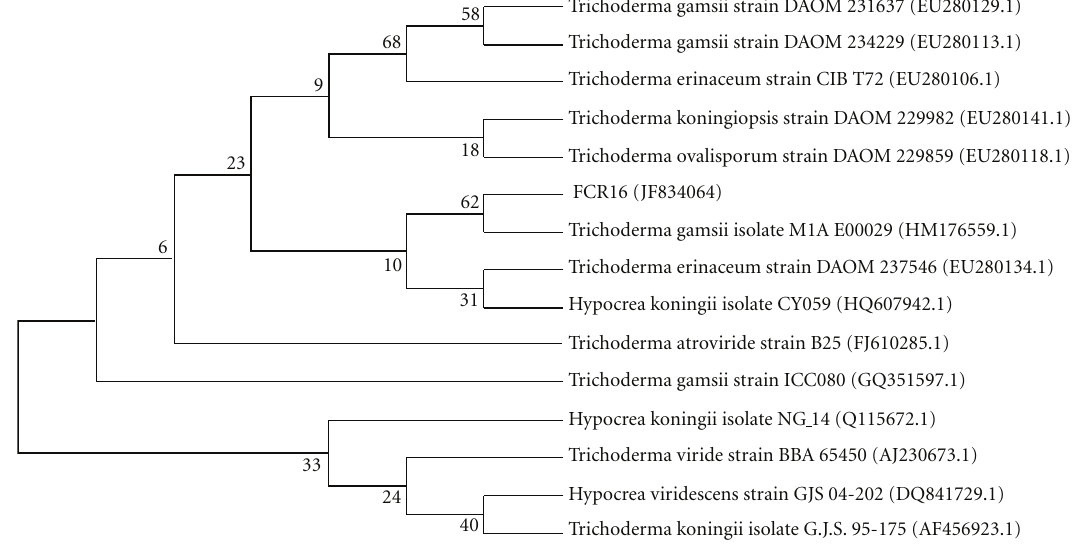
Figure 1: Phylogenetic a ffi liation based on 18s rRNA gene sequence comparison over 561 nucleotides showing the relationship of FCR16 with other fungal strains. The value at node represents percentage of 1000 bootstrap replicates. Number in bracket represents GenBank accession